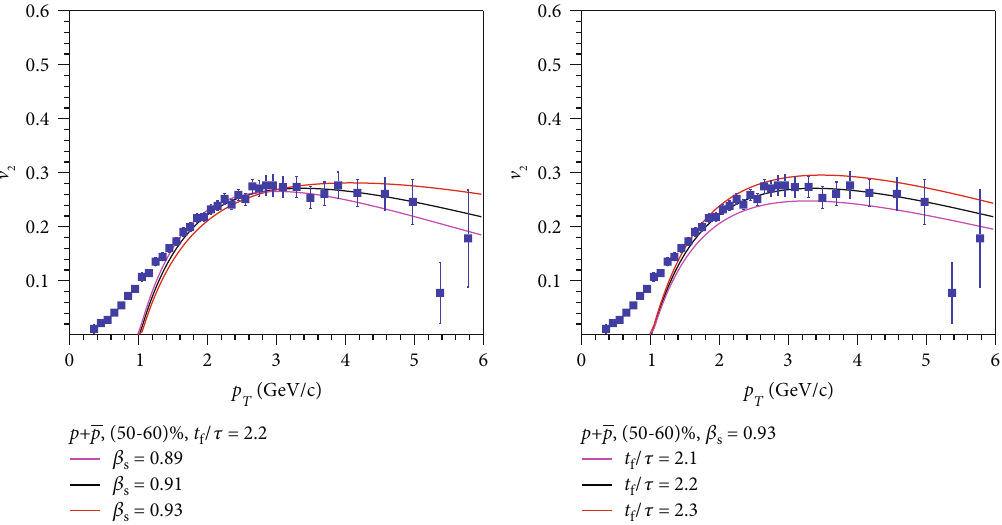
ffiffiffiffiffiffiffiffi p = 2 : 76 TeV . Symbols are s NN